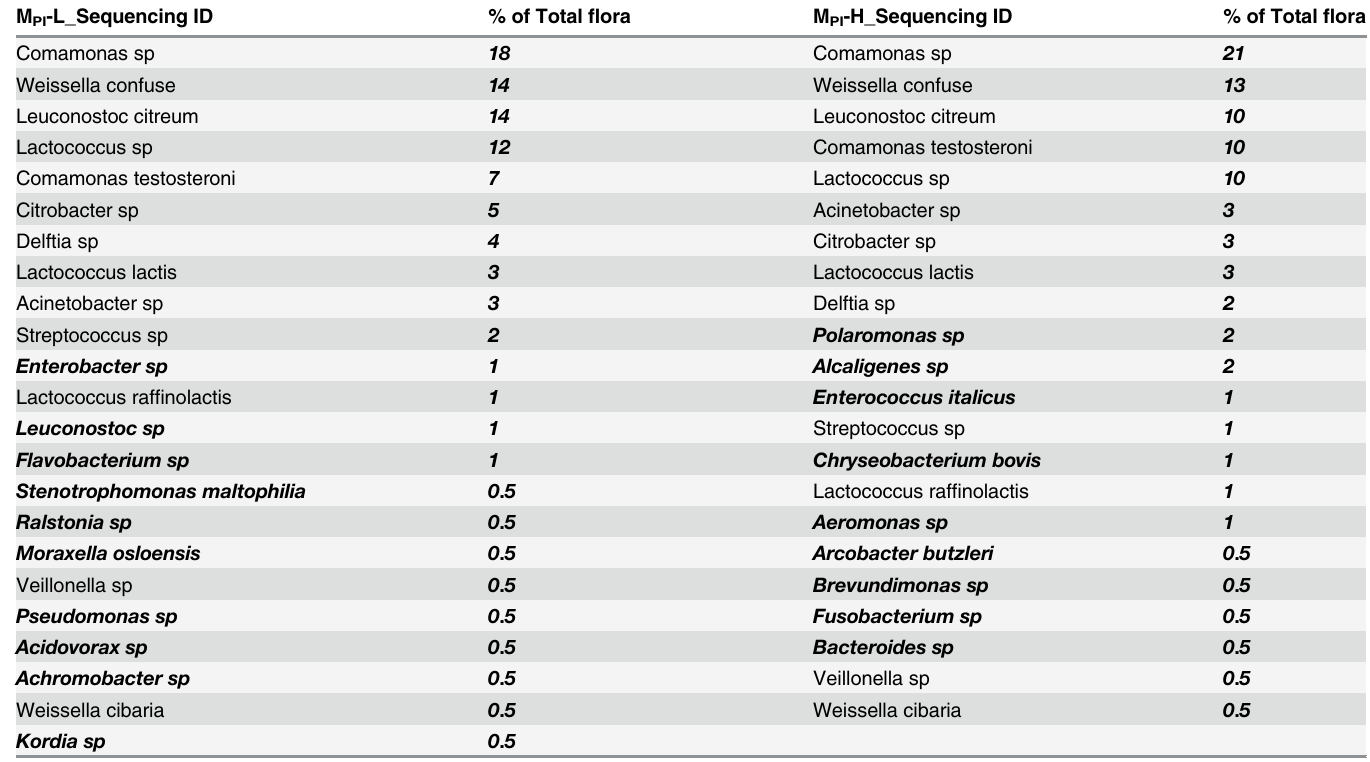
Table 1. The composition of microbiota in M PI -L and M PI